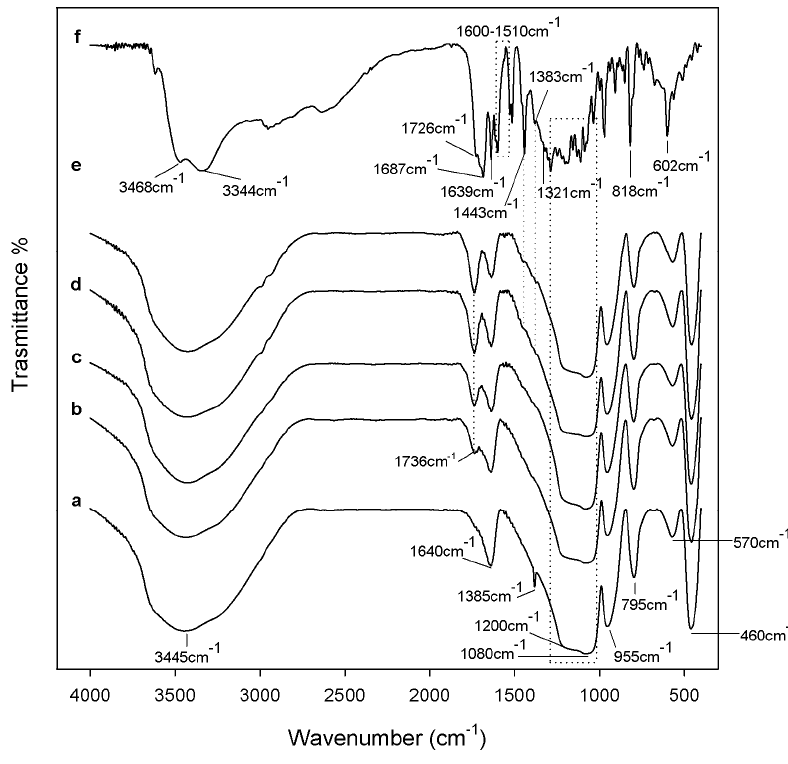
Figure 2. FT-IR spectra of ( a ) pure SiO 2 ; ( b ) SiO 2 /CGA, 5 wt%; ( c ) SiO 2 /CGA, 10 wt%; ( d ) SiO 2 /CGA, 15 wt%; ( e ) SiO 2 /CGA, 20 wt%; and ( f ) pure CGA.